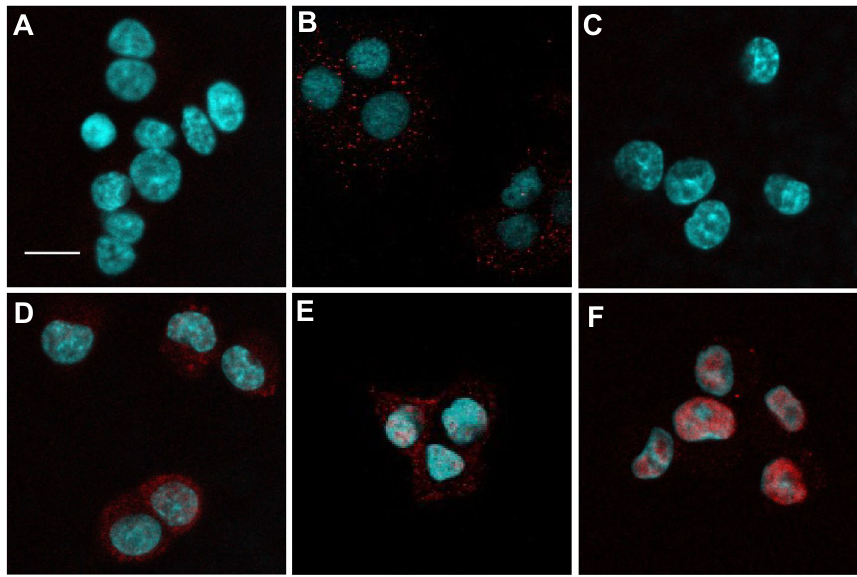
Figure 3. The effect of MG-132 treatment onto the intracellular localization of phosphorylated p38, JNK and c-Jun proteins in PC12 cells by means of confocal fluorescence laser scanning microscopy. Representative microscopic images show p-p38 ( A , D ), p-JNK ( B , E ) and p-c-Jun ( C , F ) signals in untreated ( A – C ) or 2.5 µM MG-132-treated [6 h for ( D ) and 24 h for ( E , F )] samples, respectively. The phosphorylated p38, JNK and c-Jun signals are shown in red and nuclei were counterstained with Hoechst 33342 (blue) on all panels. The scalebar on panel ( A ) (10 μm) applies to all ( A–F )